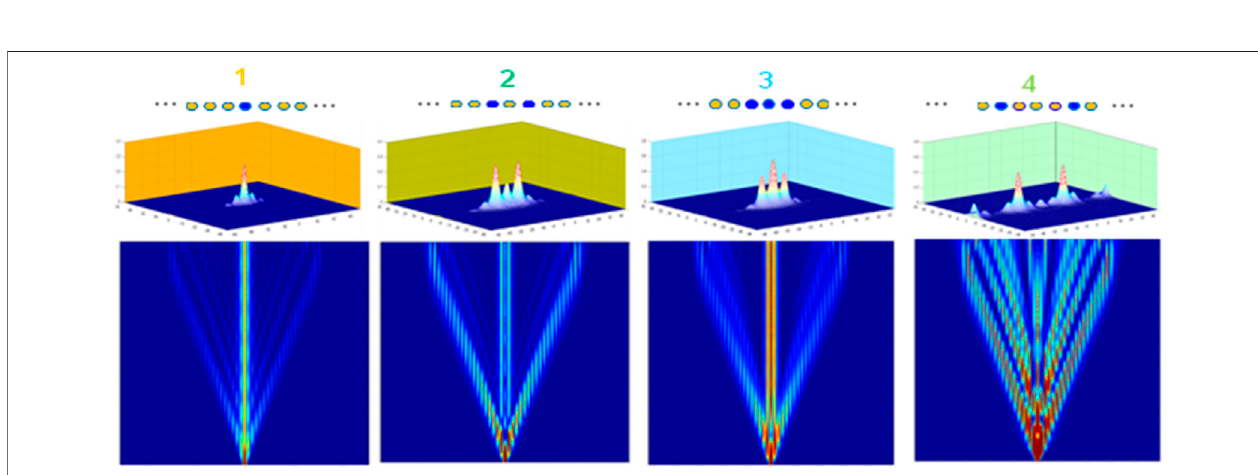
FIGURE2| Lightpropagation inBPLs A 1 , A 2 , A 3 ,and A 4 (from left to right ).Figures intheorder from bottom to top :top-view, 2Dfront-view,3Dfront-view ofthe output distributions of photons (power), and the binary photonics lattices are on top of each distribution. Red arrows indicate input signal λ (cid:1) 1.55 μ